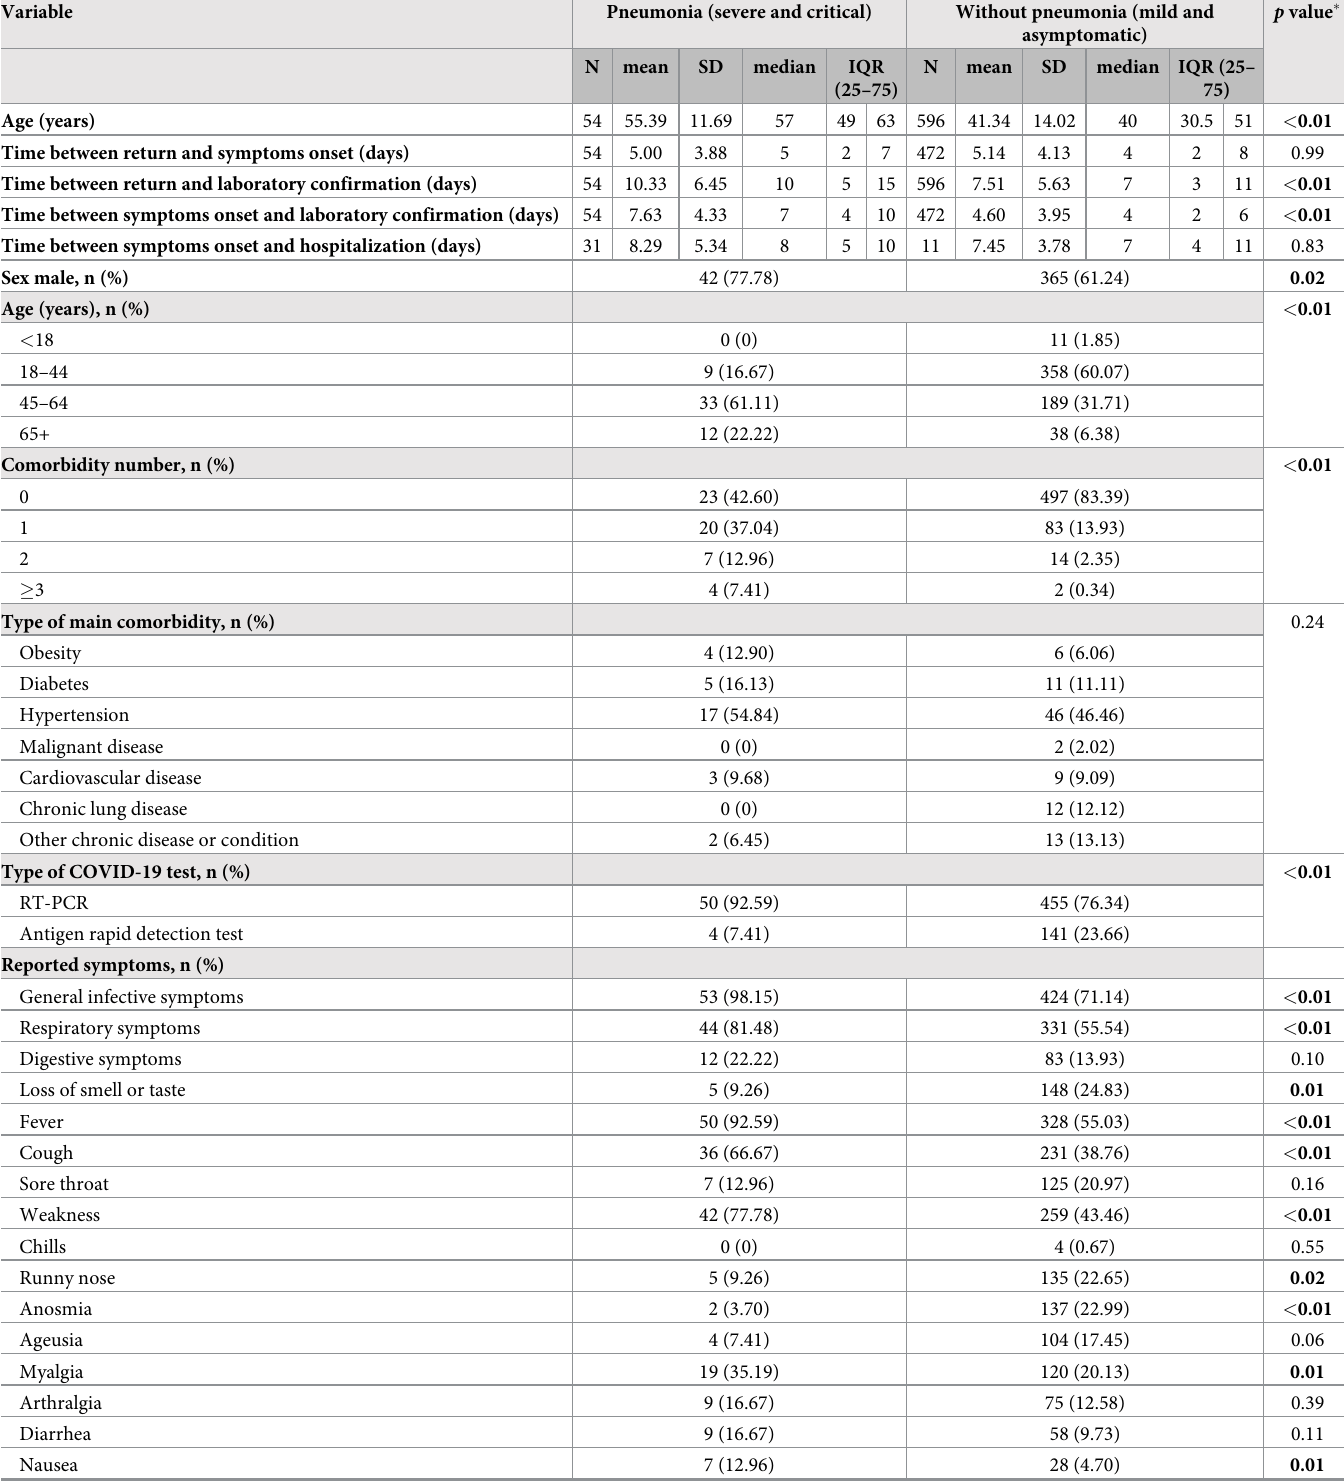
Table 3. Sociodemographic, epidemiological, and clinical characteristics of COVID-19 travel associated cases in Vojvodina, Serbia, in the period March 6—Decem- ber 31, 2020, by pneumonia